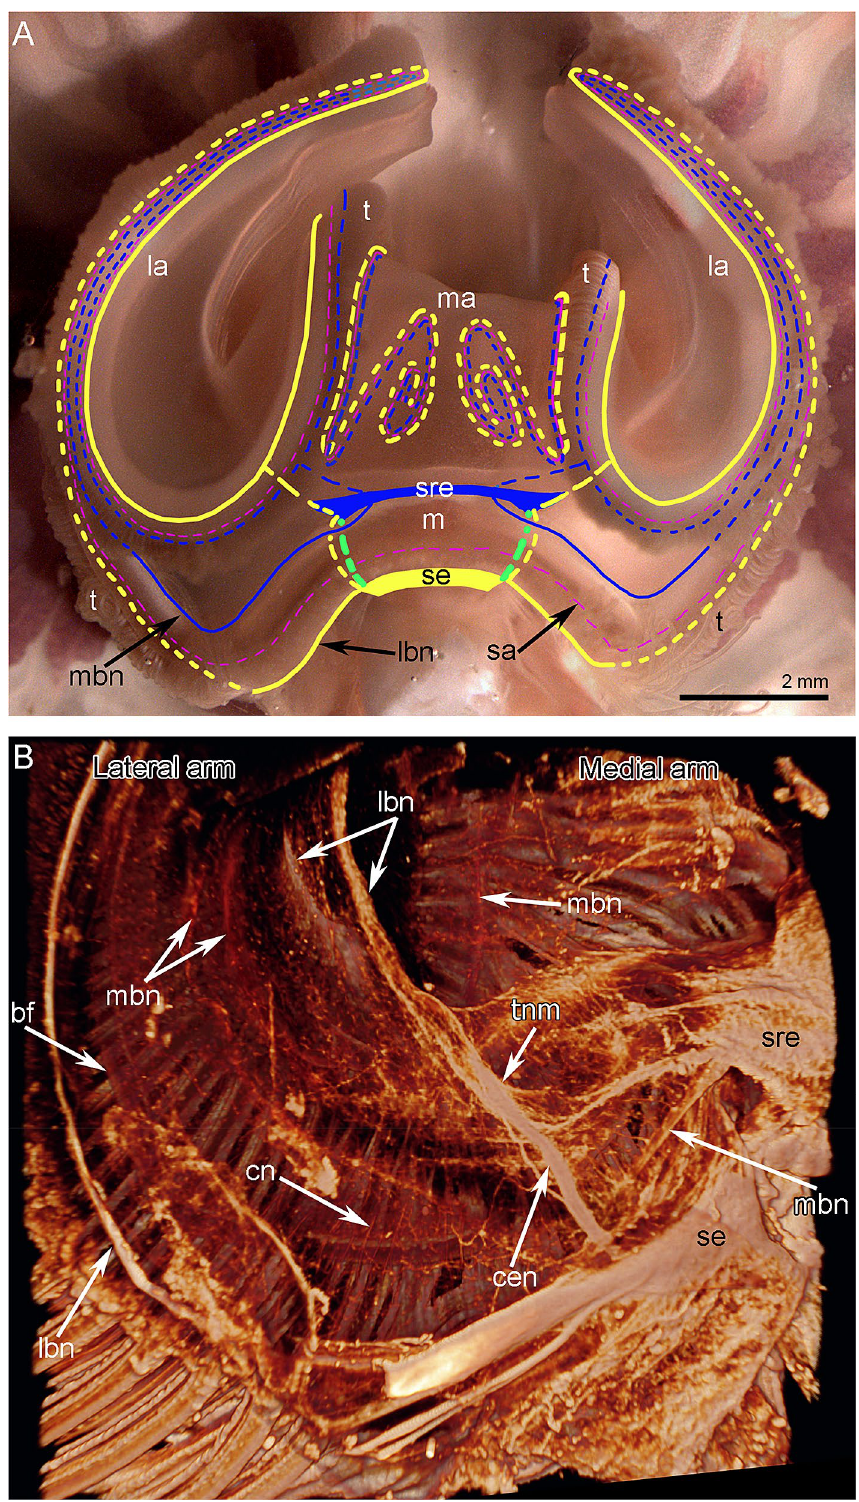
Figure 2. Organization of the central nerous system in Coptothyris grayi . ( A ) The photograph of live plectolophe with scheme of location of major nerve elements. Nerves, which are screened by lophophore structures (tentacles and brachial fold), are shown by dotted lines. Solid lines indicate nerves, which extend exactly on the lophophore surface. ( B ) Central portion of the lophophore with parts of lateral and median arms; volume rendering after immunostaining against acetylated alpha-tubulin; CLSM. Abbreviations: bf—brachial fold; cen—circumenteric connective; cn—cross nerve; la—lateral arm; lbn—lower brachial nerve; m—mouth; ma—medial arm; mbn—main brachial nerve; sa—second accessory brachial nerve; se—subenteric ganglion; sre—supraenteric ganglion; t—tentacles; tnm—thick nerves extending to the median